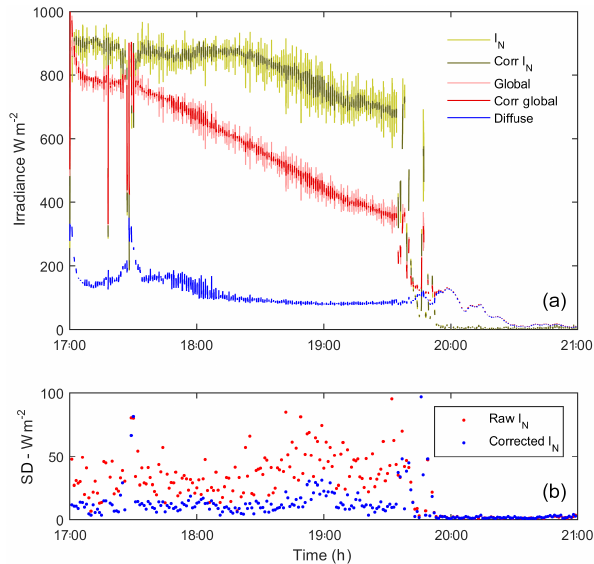
Figure 5. SPN1 tilt correction illustration data for 30 October 2014. (a) Uncorrected I N (light green) and corrected I N (dark green); un- corrected and corrected I G (light and dark red) together with I D (blue). (b) Standard deviation for uncorrected I N (red) and cor- rected I N